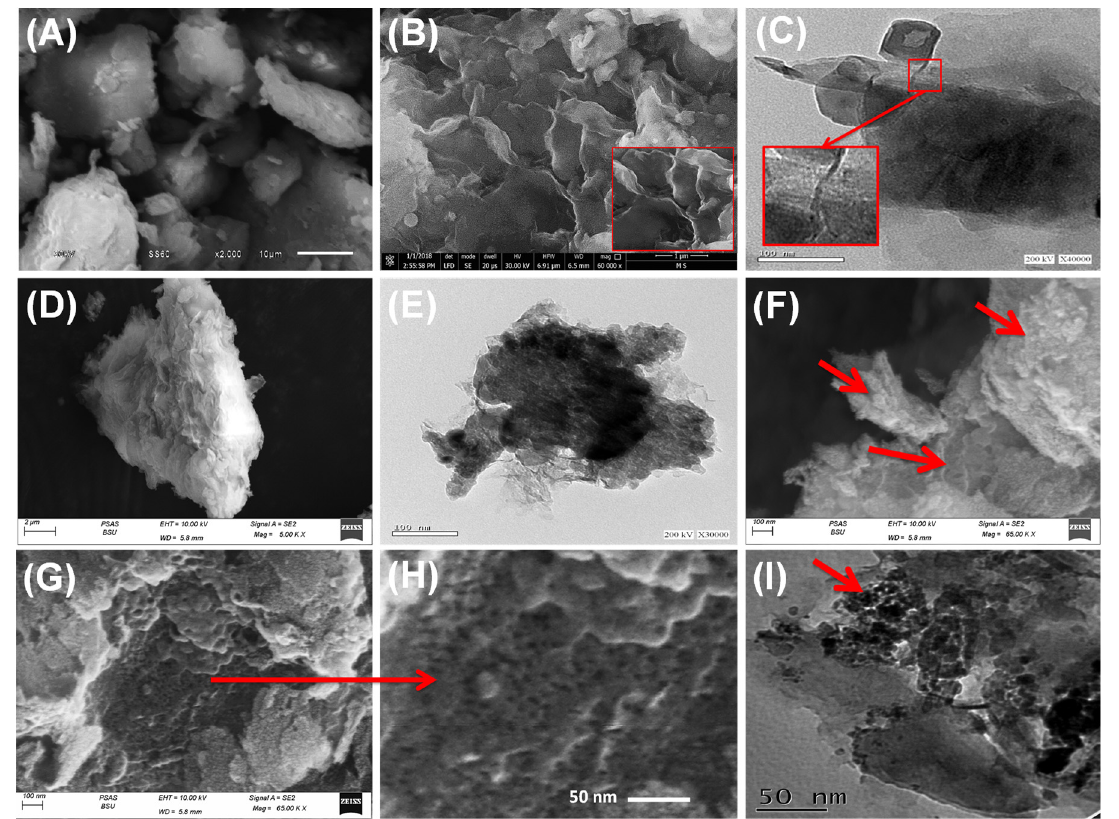
Figure 2. SEM image of raw bentonite ( A ), high-magnification SEM image on the surface of bentonite, and the selected area portrays the cornflakes structure of montmorillonite ( B ), HRTEM images of the used raw bentonite ( C ), SEM image of CN/BE particles, ( D ) HRTEM image of the synthetic CN/BE particles ( E ), SEM image for the surface of the synthetic Zn@CN/BE structure (red arrows refer to the decorated Zn metal on the surface) ( F ), high-magnification image of the supported zinc nanoparticles and the interstitial pores ( G , H ), and HRTEM image of the synthetic Zn@CN/BE structure (red arrows refer to the pillared zinc metal between the bentonite layers) ( I ).